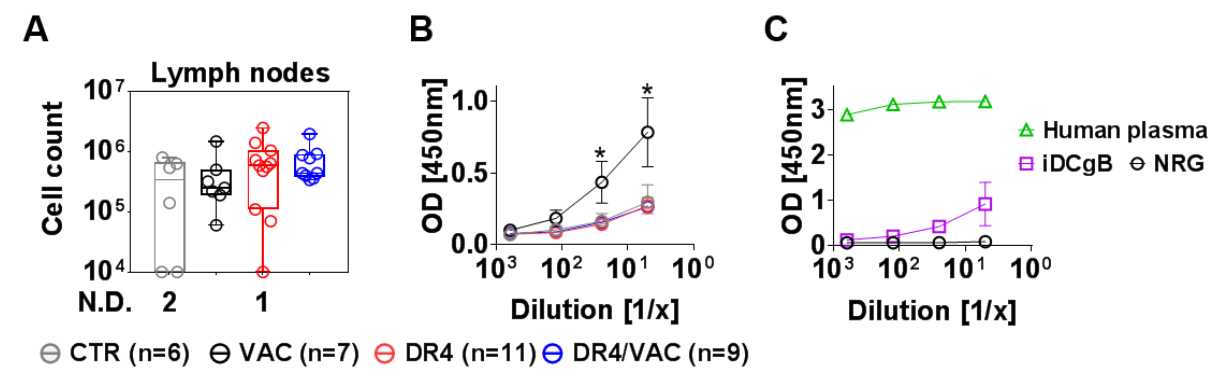
Figure 11. DR4/VAC promotes LN cellularity and VAC results in anti-gB IgG + responses. ( A ) Total cell count in lymph nodes. No detection (N.D.) refers to the number of mice; ( B , C ) detection of IgG reactivity against gB in plasma by ELISA. * p < 0.05 when comparing DR4 vs. VAC. Statistical analyses were performed using the Welch t -test applied to log data.